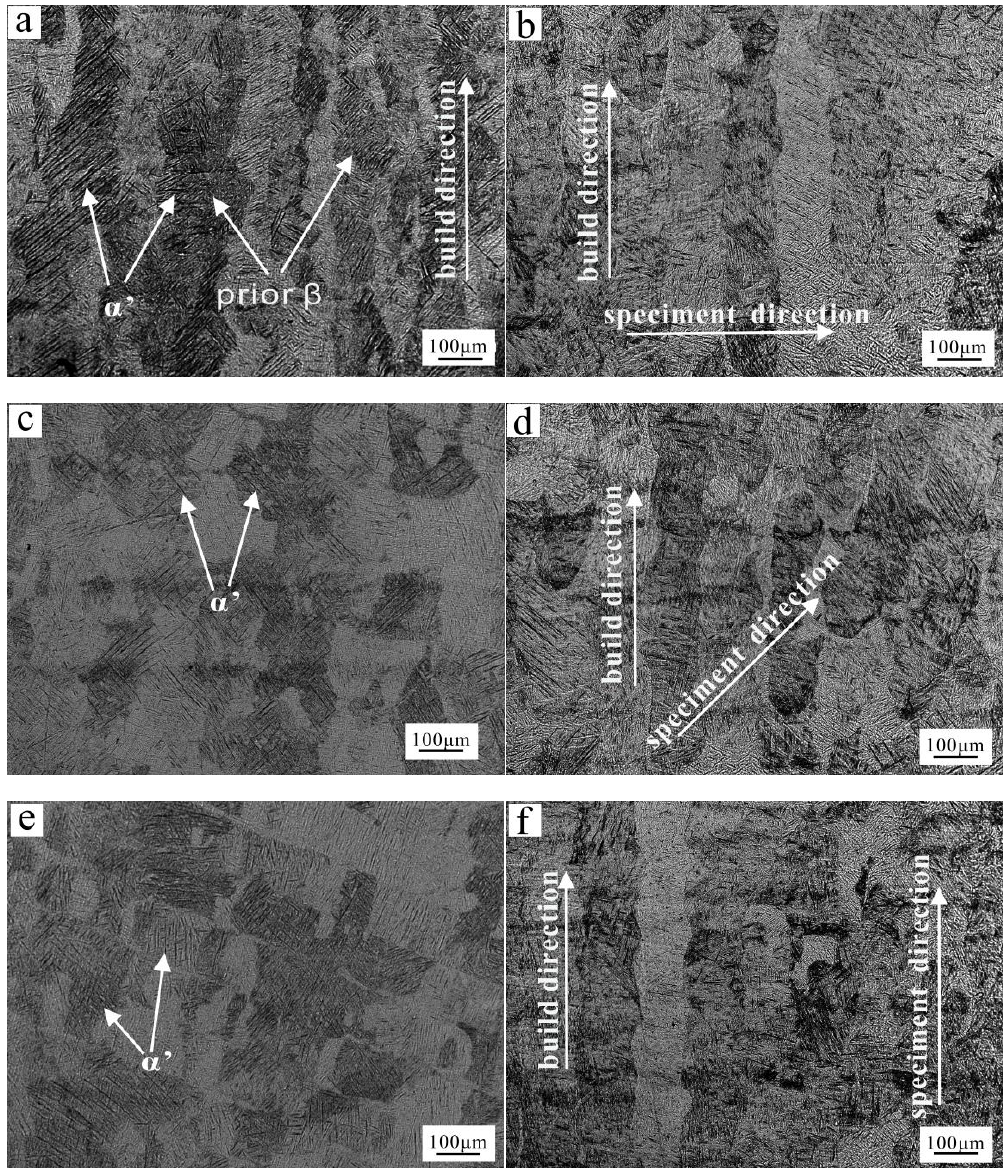
Figure 5. Optical microstructure of SLM-produced Ti-6Al-4V samples with di ff erent build orientations. Sample A (cross section ( a ) and longitudinal section ( b )) and sample B (cross section ( c ) and longitudinal section ( d )) and sample C (cross section ( e ) and longitudinal section ( f )).